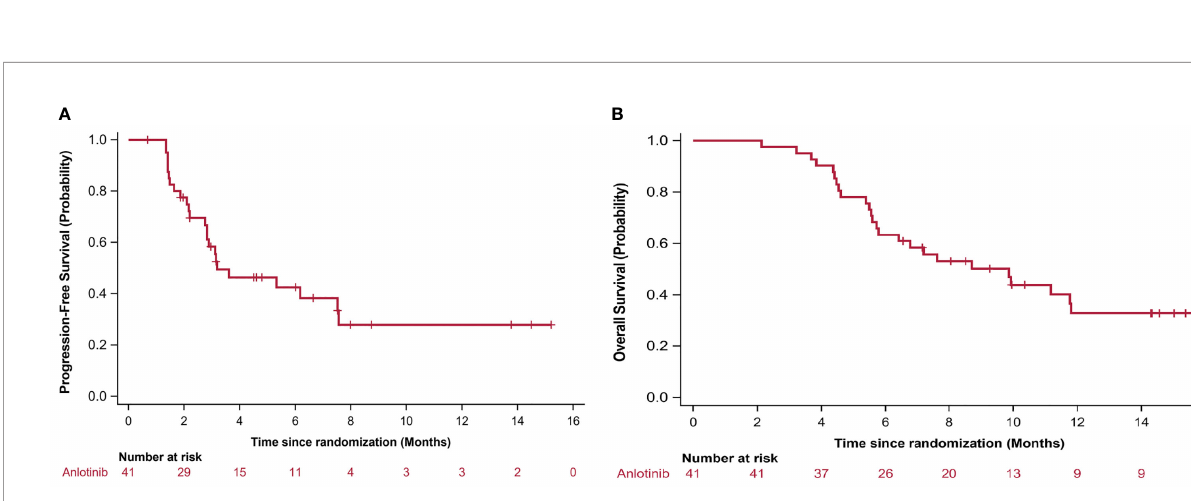
FIGURE 3 | Kaplan – Meier curves for (A) progression-free survival (PFS) and (B) overall survival (OS). PFS and OS was assessed in all patients.